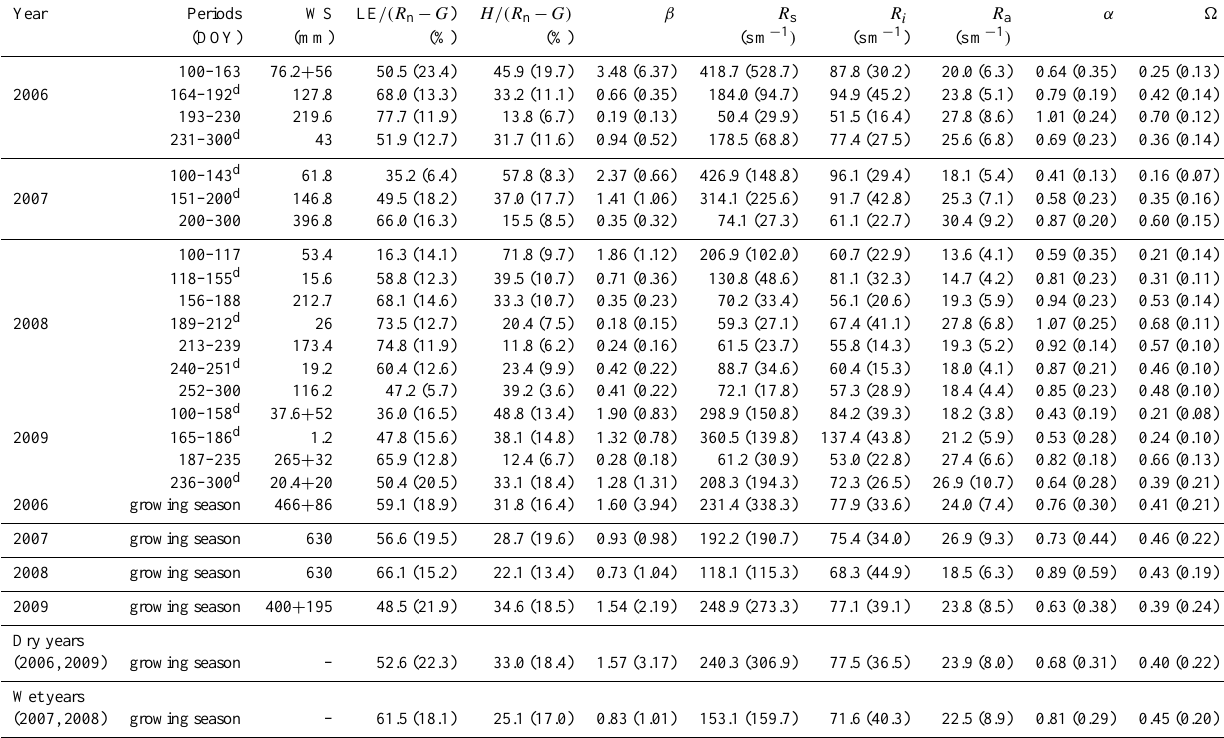
Figure 7. The relationships between surface resistance ( R s ) and LE / LE eq (Priestley–Taylor coefficient) during growing season of the wet (a) and dry (b) year. Table 3. The value of the soil water supply (WS), energy partitioning ratios, and biophysical variables in the different growing seasons during